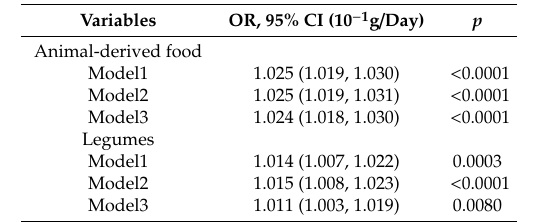
Table 4. Odds ratio (95% CI) for hyperuricemia associated with animal derived food intake or legumes